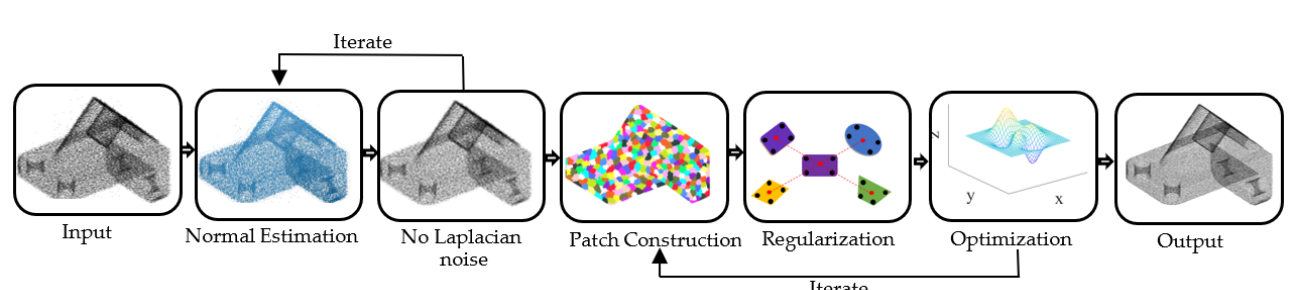
Figure 2. The flowchart of the proposed point cloud denoising algorithm.